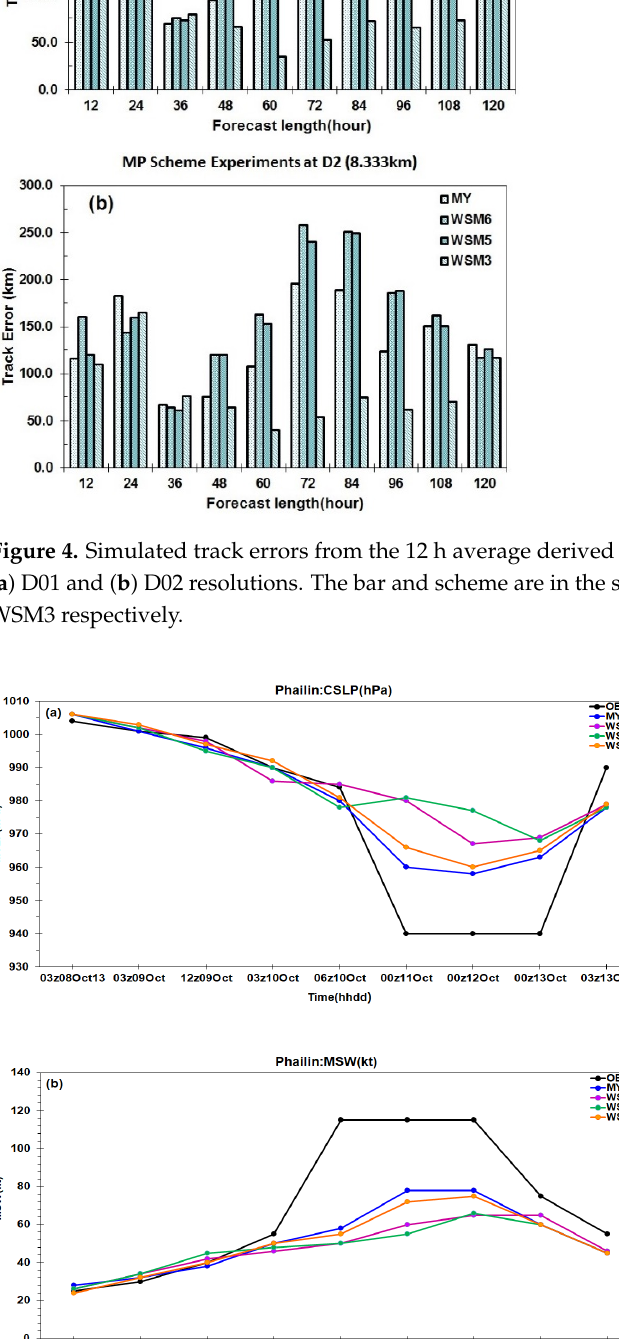
Figure 5. Intensity simulation of ( a ) MSLP (hPa) and ( b ) 10 m maximum sustained wind (MSW; knots) derived from IMD and WRF model experiments during different stages of Phailin at 8.333 km resolution.